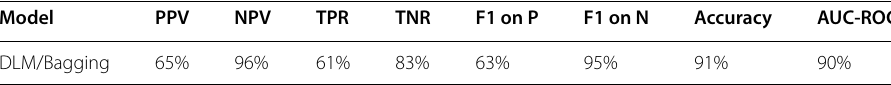
Table 16 Testing results with